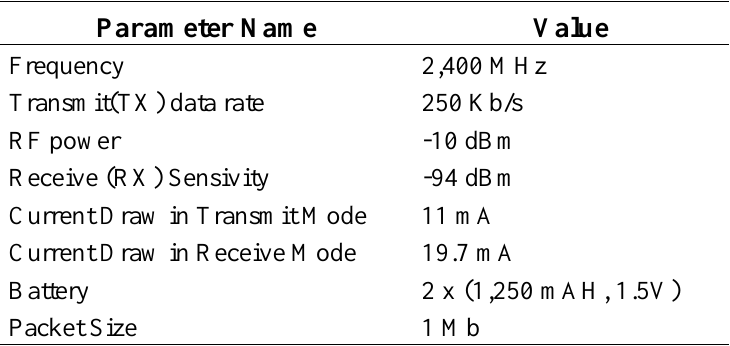
Table 1. Parameter values of the hardware used in simulations.